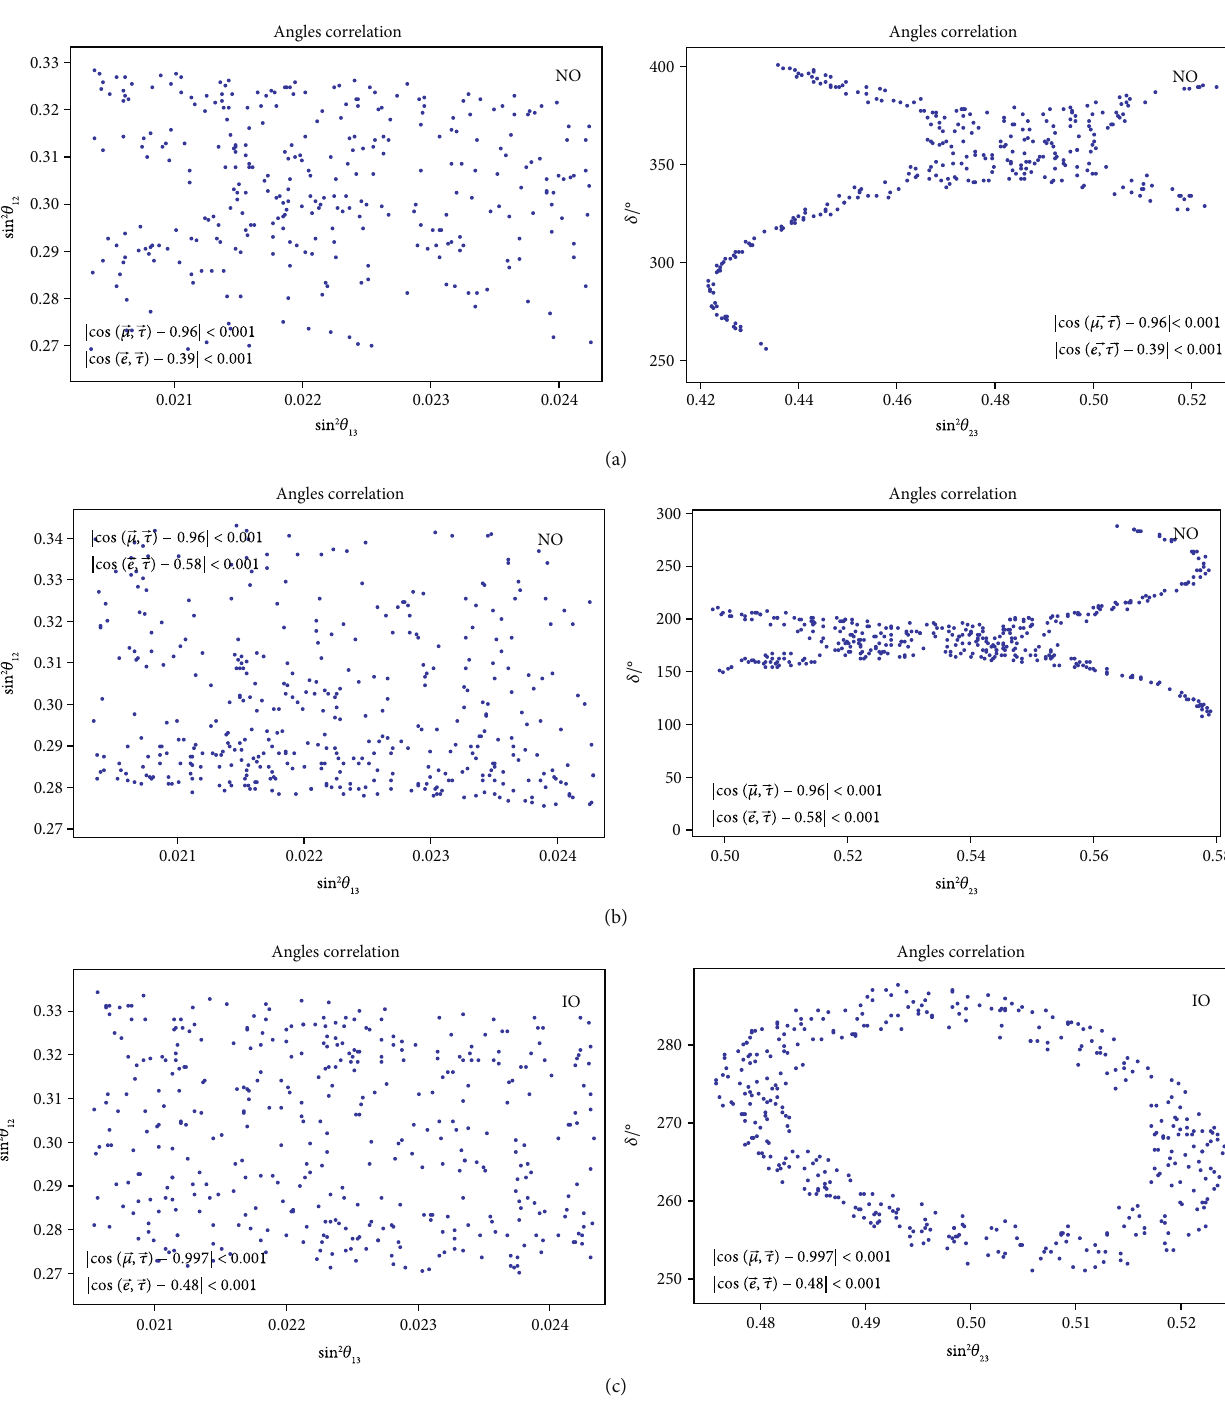
Figure 8: Leptonic mixing parameters constrained by the correlations between two included angles of ( cos ð μ Table 4. (a) NO case with the constraints of j cos ð μ ! Þ − ! of j cos ð μ , τ 0 : 96 j < 0 : 001 and j cos ð e − 0 : 48 j < 0 : 001